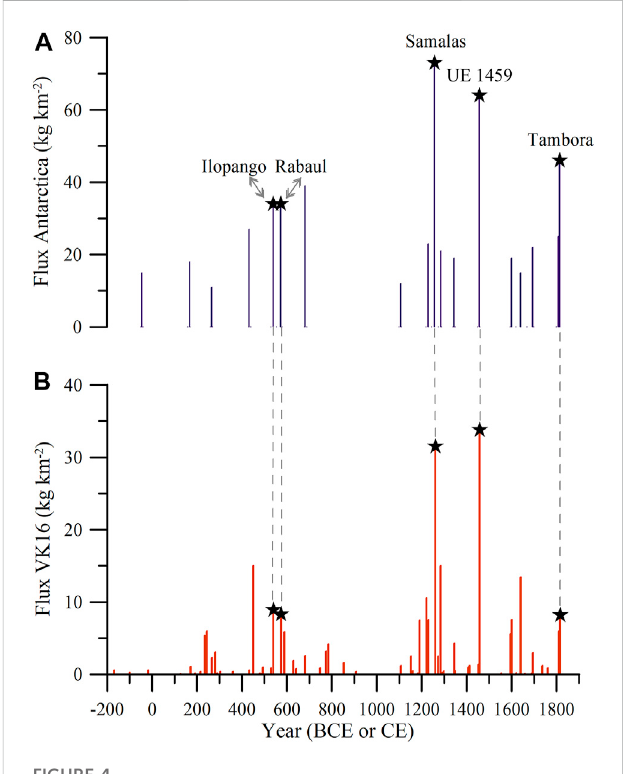
Time-series of thevolcanic peaks found in (B) the VK16 core versus (A) the time-series of the largest volcanic events found in the Antarctic snow and fi rn deposits according to (Sigl et al., 2015). By the stars the peaks used to tune the VK16 depth-age function are